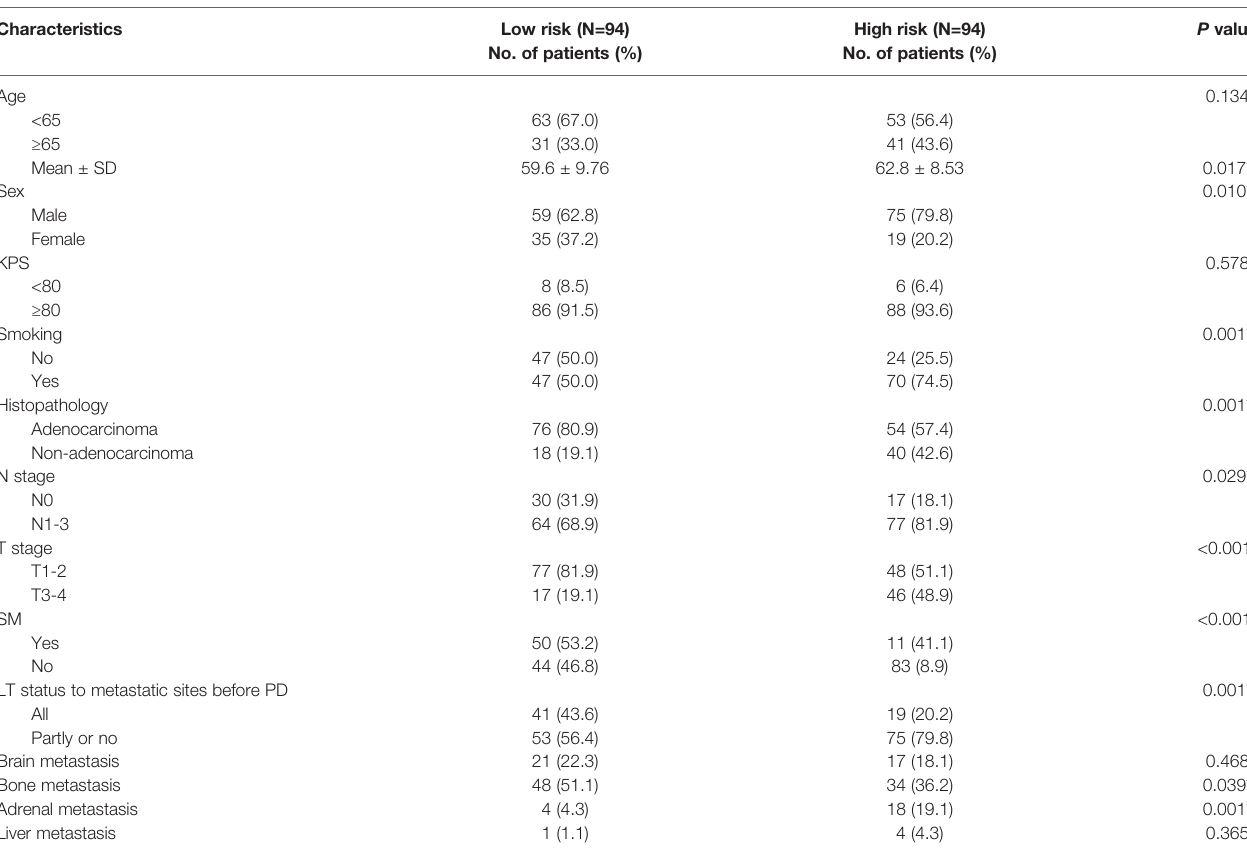
TABLE 4 | Clinical characteristics of low- and high-risk patients in the training set.